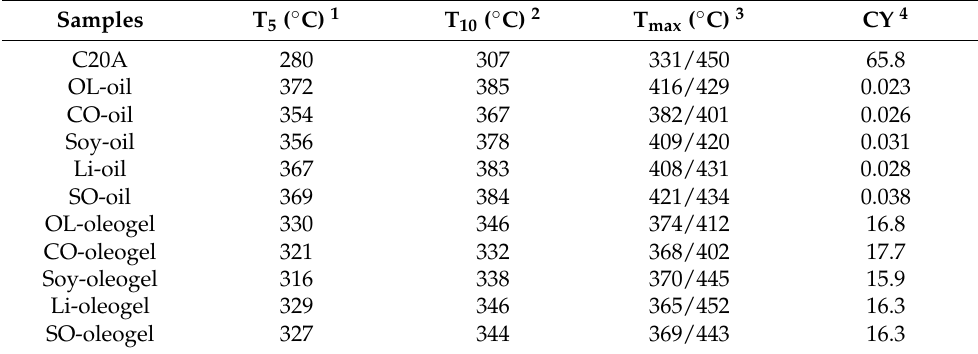
Table 2. Thermal property data of C20A organoclay, vegetable oils and oleogels formulated with different vegetable